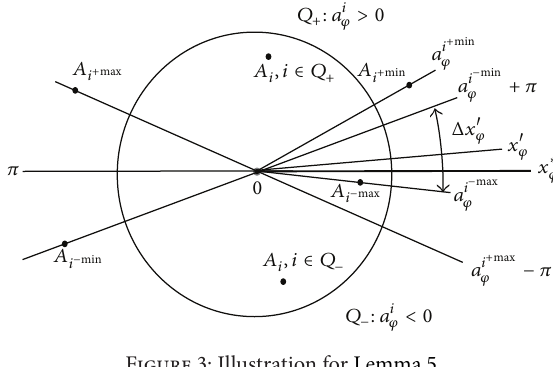
Figure 3: Illustration for Lemma